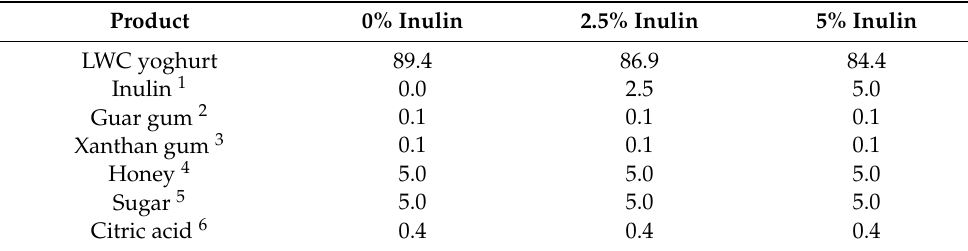
Table 1. Formulations used for the production of frozen yoghurts (% w / w ). Product 0%